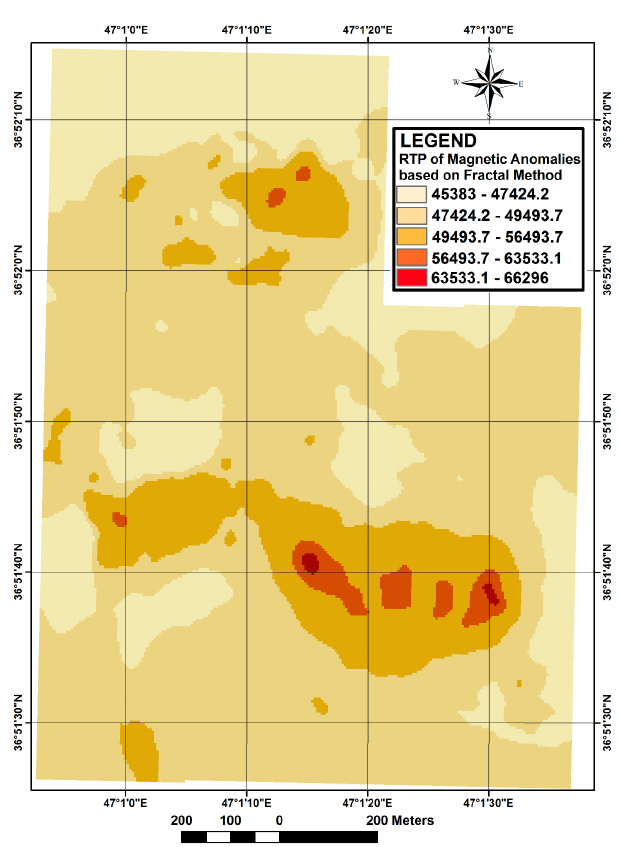
Figure 7. RTP map of Qoja-Kandi based on the C – A